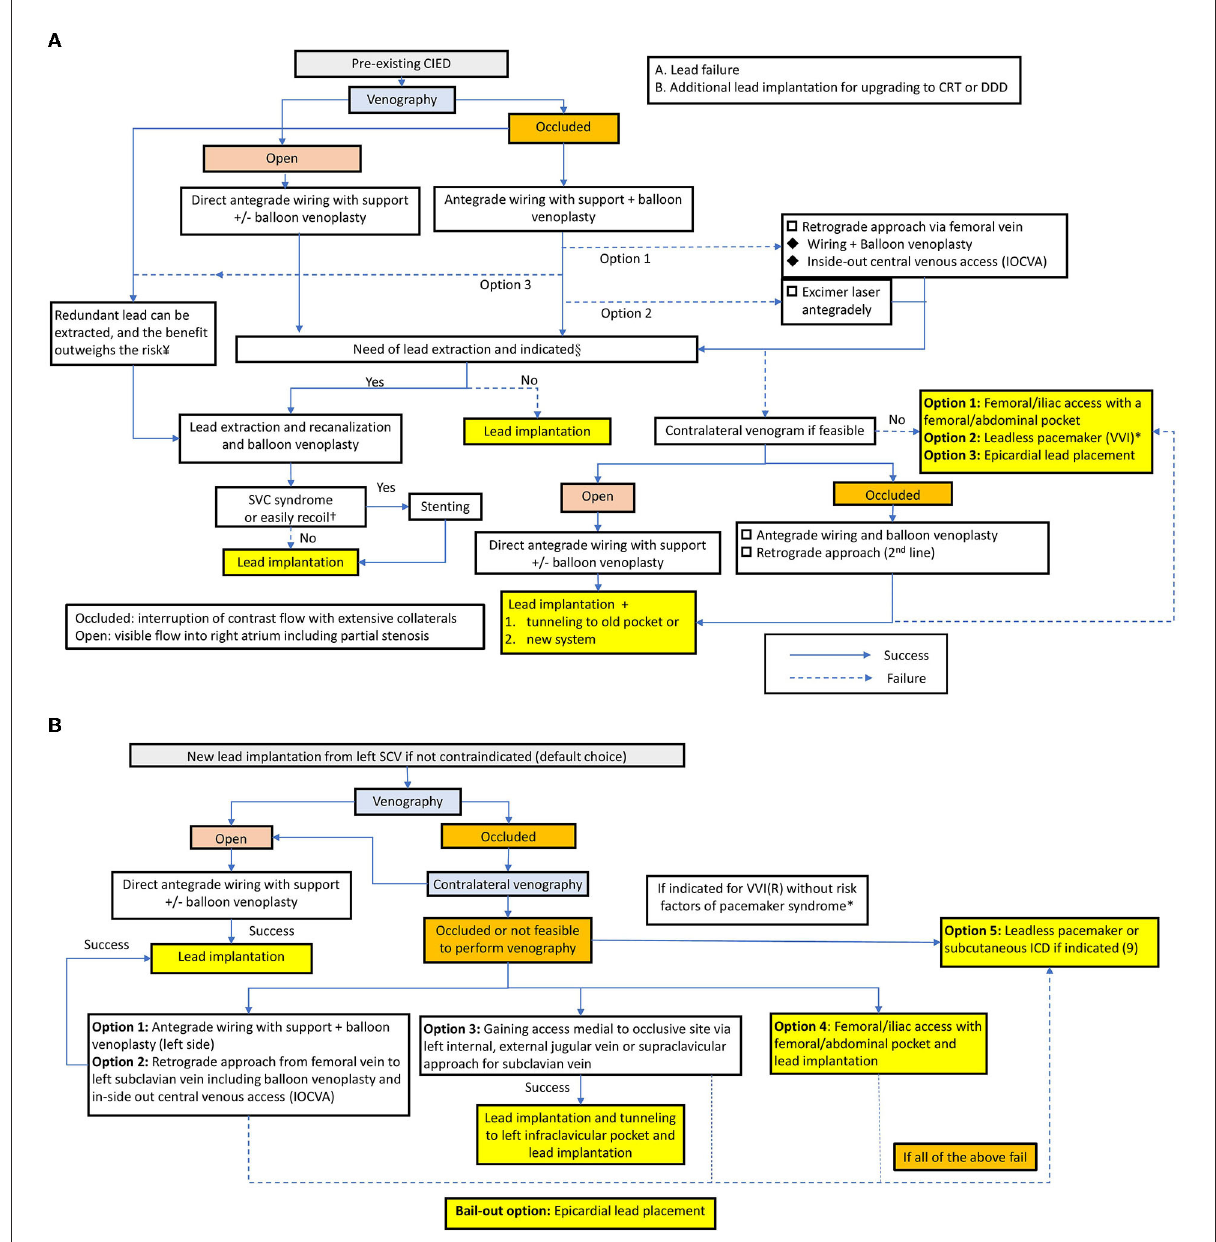
FIGURE3 (A) Treatment algorithm in patients with a preexisting CIED. *In the setting of the pre-existing VVI mode with lead failure. §According to the Heart Rhythm Society expert consensus statement (9), the indications are as follows. Class I: Lead infection, thromboembolic events related to thrombus on the lead, SVC stenosis or occlusion preventing implantation of a necessary lead, planned stent deployment in a vein containing a lead, life-threatening arrhythmias secondary to retained leads. Class IIa: Severe chronic pain at the device or lead insertion site, CIED location interfering with the treatment of malignancy, if CIED implantation would require more than 4 leads on one side or more than 5 leads through the SVC, an abandoned lead interfering with the operation of a CIED system. In patients with lead infection, a new lead can be reimplanted after a complete antibiotic course. The duration depends on the type of infection and is described in the HRS expert consensus. U Extraction of lead as a first-line approach to lead revision or device upgrade for patients with venous occlusion can be useful in experienced centers, and the priority depends on the operator’s discretion and expertise (9). † If the vascular recoil would hinder the lead implantation or patients present with SVC syndrome, venoplasty with subsequent stenting is needed (9). (B) Treatment algorithm in patients without preexisting CIED. *Indications for VVI: fixed atrial tachyarrhythmia with symptomatic bradycardia; Severe pacemaker syndrome occurred in nearly 20% of VVIR-paced patients, and the baseline predictors for pacemaker syndrome are lower sinus rate and higher programmed pacemaker rate